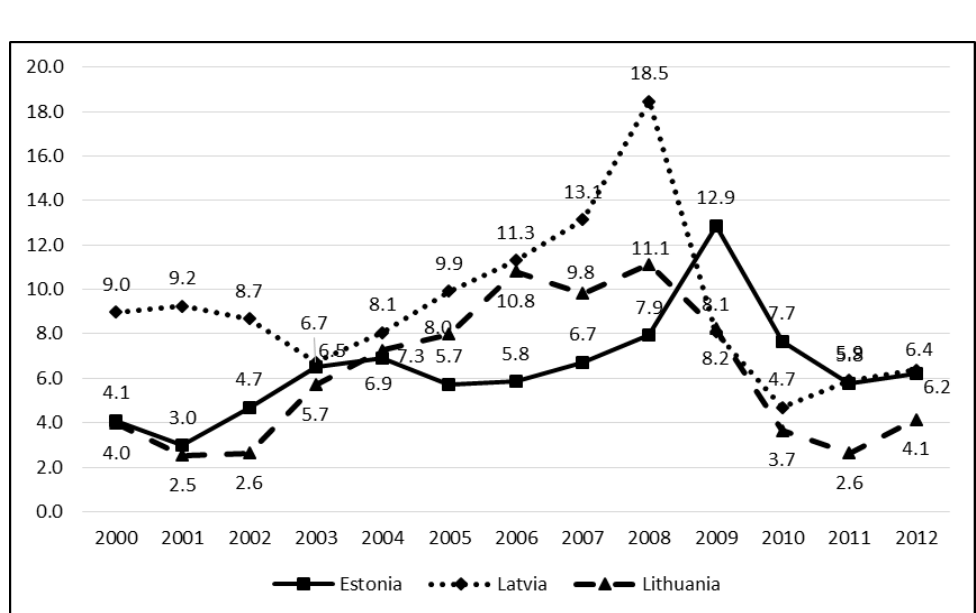
Fig. 3. Implicit tax rates in % ‒ corporate income in Estonia, Latvia and Lithuania (Developed by the author; TAXUD,